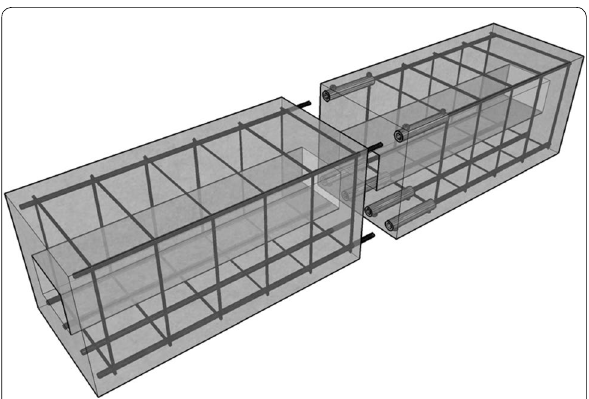
Fig. 1 Configuration of segment-to-segment